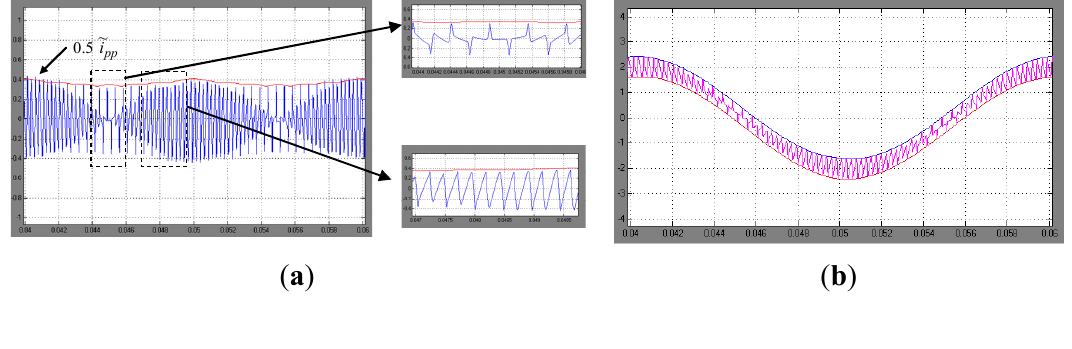
Figure 9. ( a ) Current ripple for m = 1/7. Simulation results (blue) and evaluated peak-to-peak amplitude (red envelope) for one fundamental period, with details; ( b ) instantaneous output current with calculated ripple envelopes (red and blue